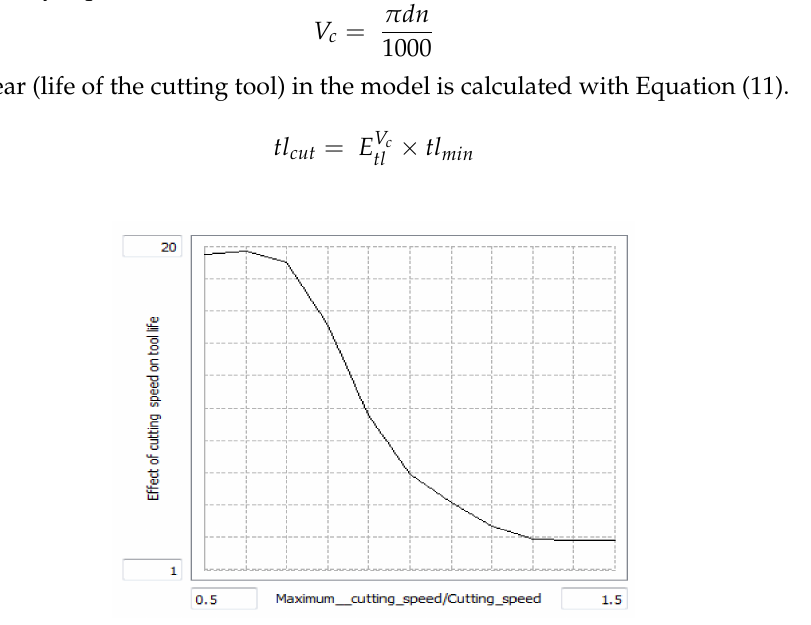
Figure 8. Behavior of the effect of the cutting speed on tool